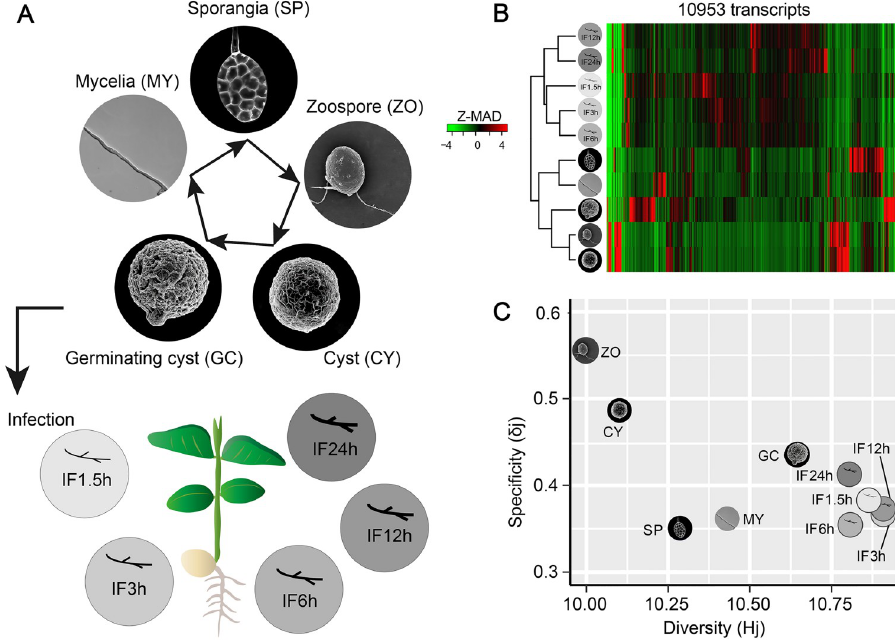
Fig 1. Overview of transcriptome data set with host infection and asexual development in P . sojae . (A) Schematic diagram of asexual development and infection stages. Asexual stages including Mycelia (MY), Sporangia (SP), Zoospores (ZO), Cyst (CY) and Germinating cysts (GC). Infection stages includes IF1.5h, IF3h, IF6h, IF12h, IF24h, which mean that samples were taken after 1.5, 3, 6, 12, 24 h inoculation onto susceptible soybean leaves. (B) Hierarchical clustering of expression matrix of transcripts in asexual and infection stages. The expression matrix was removed of transcripts with low expressions. (C) Correlation analysis of expression data from ten asexual and infection stages. x-coordinate: Hj index for quantification of transcriptome diversity; y-coordinate: δ j index for transcriptomic profile specialization.